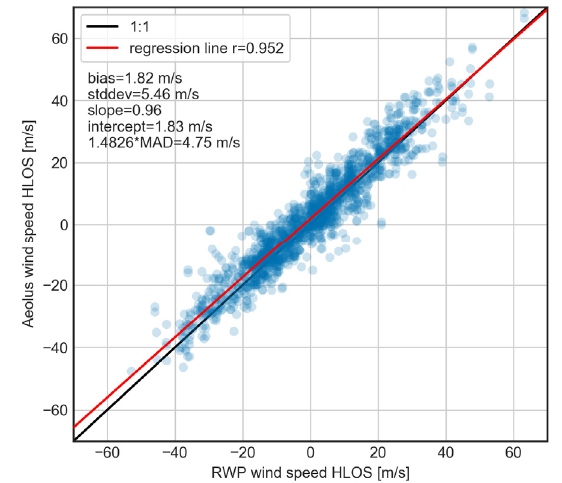
Fig. 2: Comparison of HLOS Rayleigh clear wind speed measured by Aeolus and HLOS projected wind speed from RWP measurements between 04 September 2018 and 15 January 2019. 1630 valid measurements are shown.